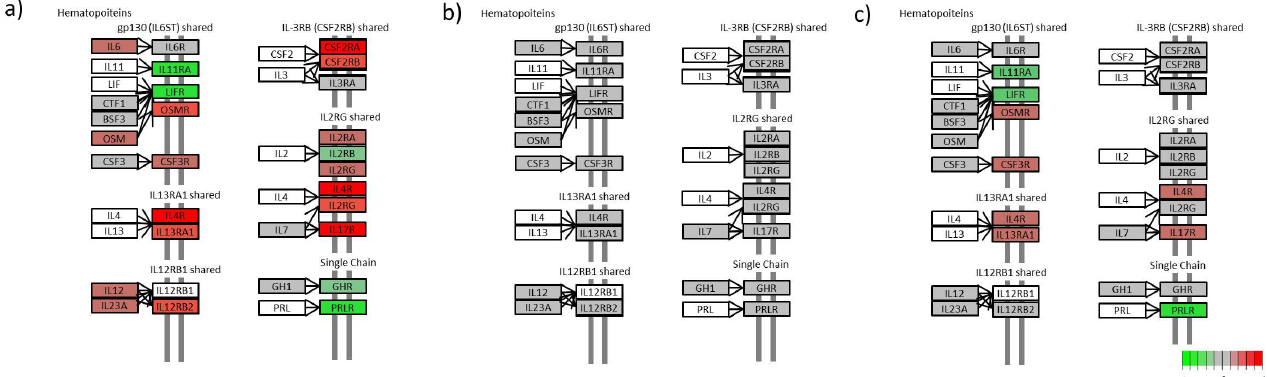
Fig 5. Cytokine-cytokine receptor interaction for the Hematopoiteins. (a) Untreatedlesionalversus nonlesional,(b) Untreatedlesionalversus 4 days after adalimumab treatment was initiatedand (c) Untreatedlesionalversus 14 days after adalimumab treatment was initiated. (Colours refer to the expressionlevel; green is downregulated, red is upregulatedin untreated lesionalpsoriaticskin, grey is not regulatedand white is not includedin our data set) (Please find list of gene names in S4 Table).